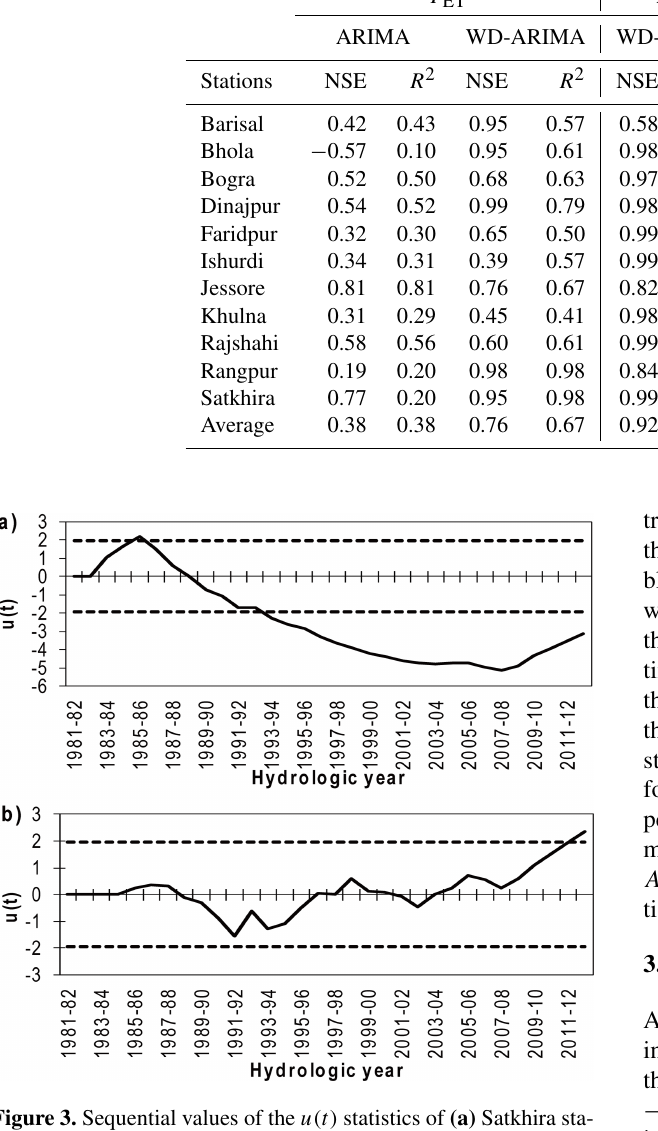
Figure 3. Sequential values of the u(t) statistics of (a) Satkhira sta- tion and (b) Bhola